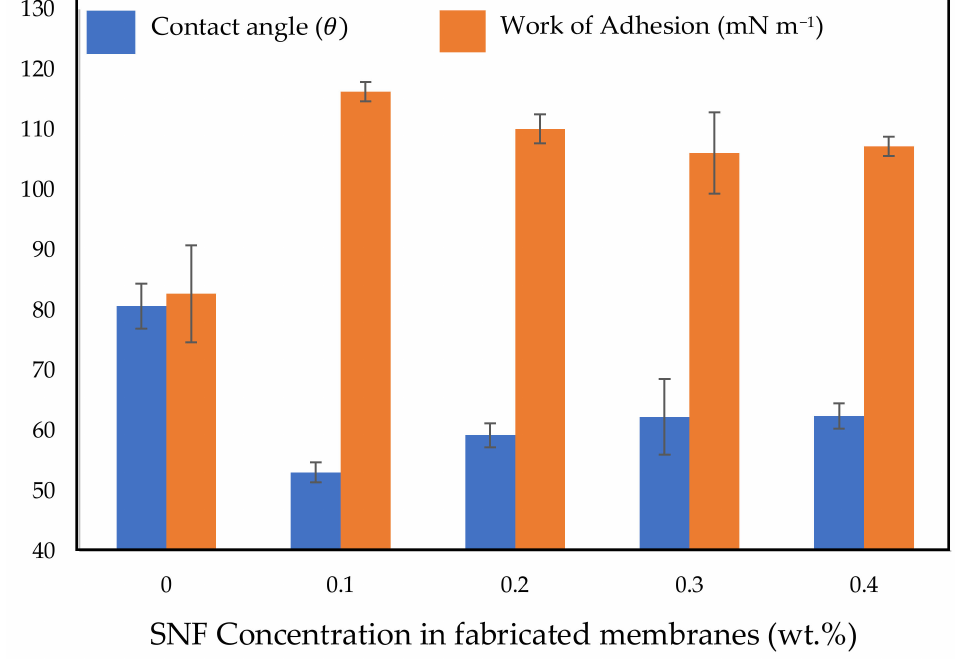
Figure 4. Contact angle and work of adhesion of the fabricated membranes at different SNF